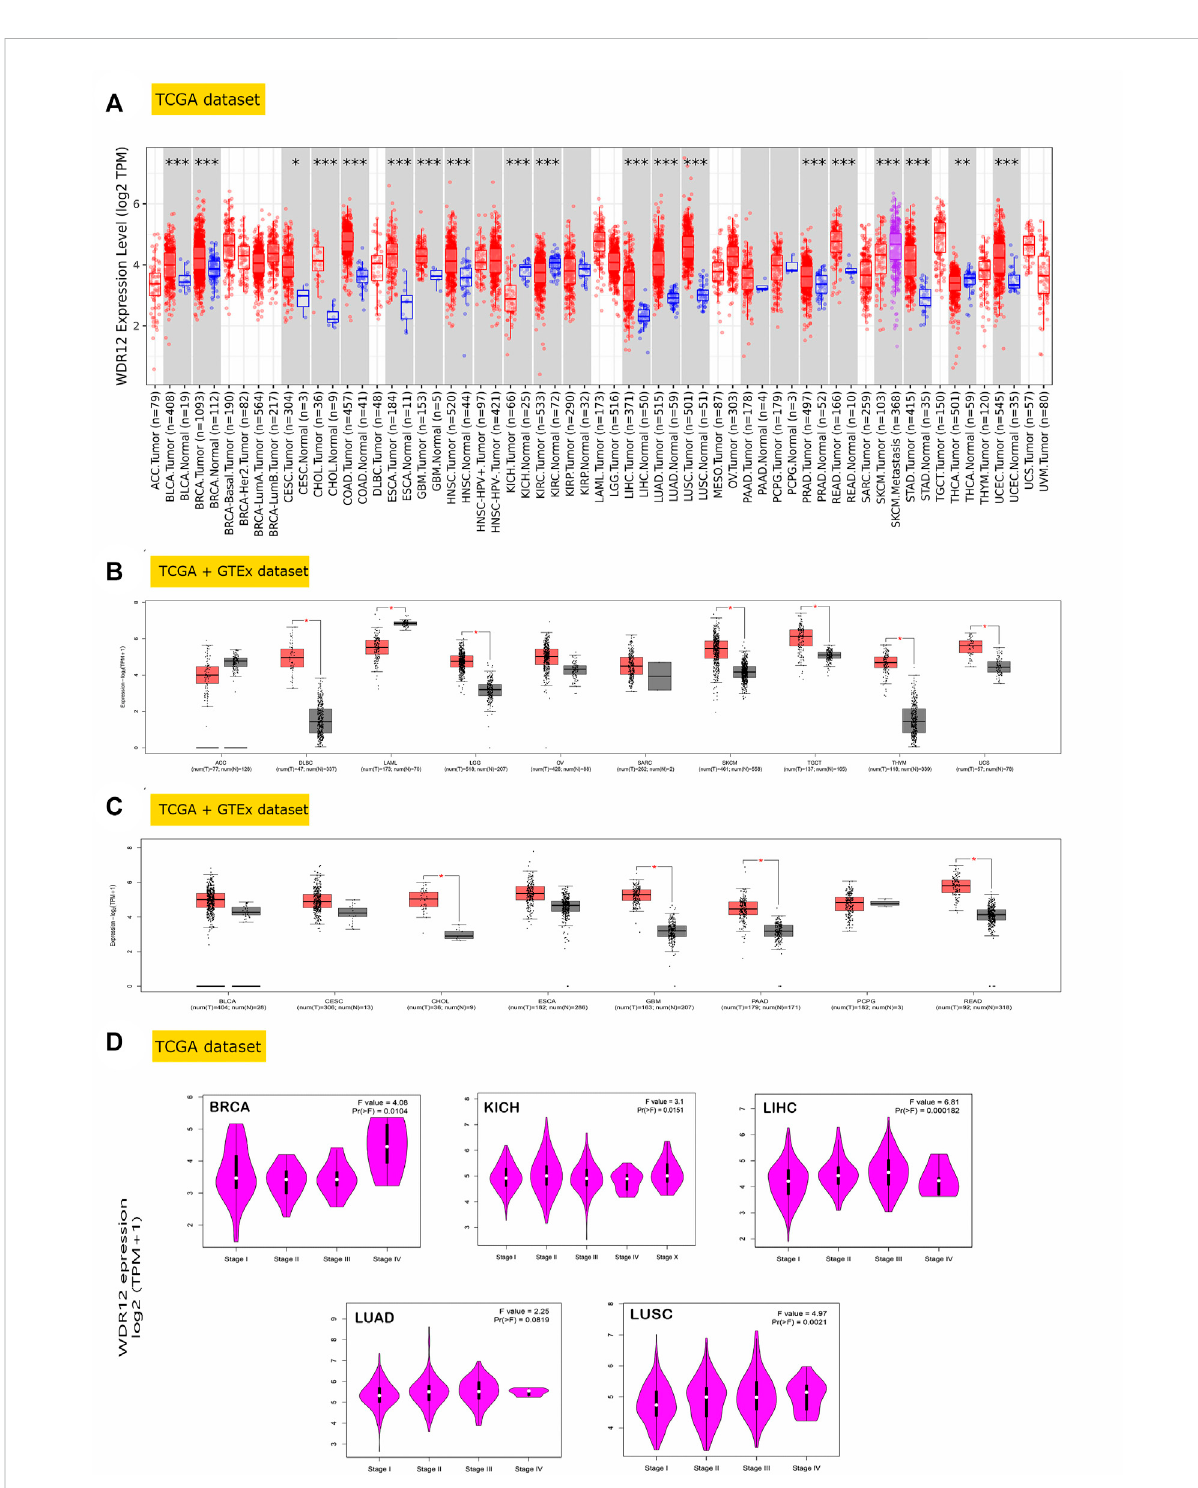
FIGURE 1 WDR12 expression assessment in human cancers. (A) Differential expression of WDR12 in a panel of TCGA tumors analyzed by TIMER2.0; (B) tumorsthatlacknormaltissueforcomparisoninTIMER2.0.DatabaseandexperiencedatrendofelevatedWDR12expressionintumorversusnormal tissue when analyzed in the GEPIA database; (C) tumors that underwent a signi fi cant WDR12 protein expression versus normal tissue; (D) tumors experienced a positive correlation between WDR12 expression and the tumor